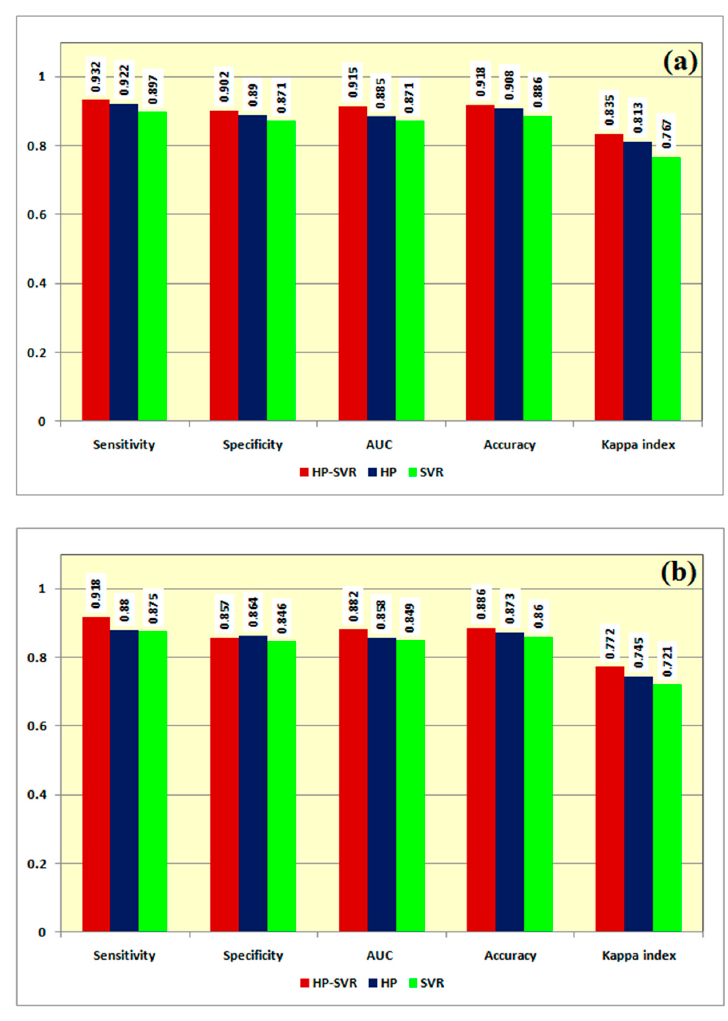
Figure 9. Performance evaluation of the flood susceptibility models; ( a ) training stage and ( b ) validating stage